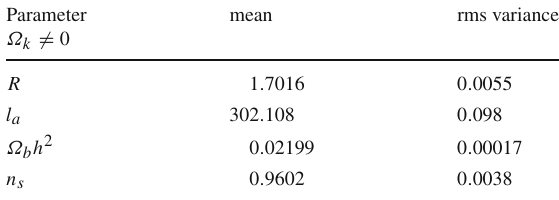
Table 16 R , l a , Ω b h 2 and n s estimated from Planck simulated